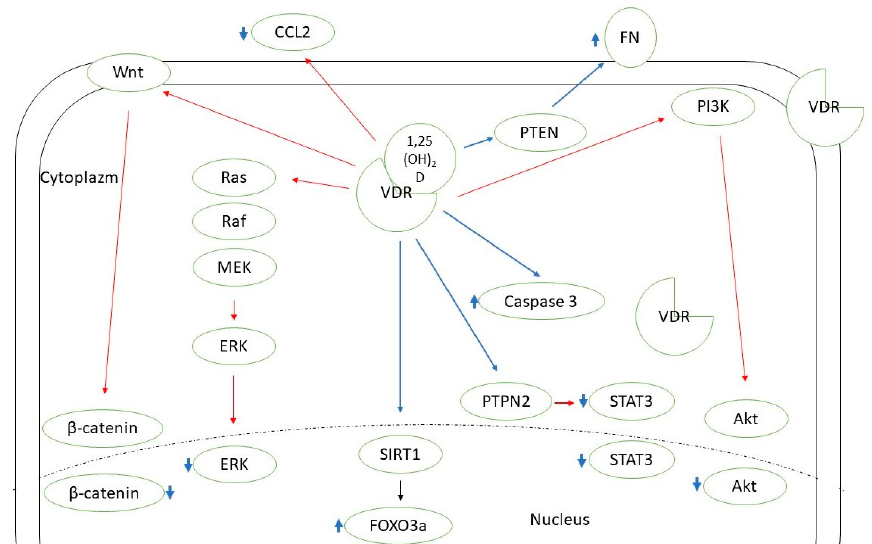
Figure 1. Known pathways mediating vitamin D action in thyroid cancer cells. CCL2—C-C motif chemokine ligand 2; ERK—extracellular signal-regulated kinase; FN—fibronectin; FOXO3a—fork- head box protein O3a; MEK—mitogen-activated protein kinase kinase 1; PI3K—phosphoinositide 3-kinase; PTEN—phosphatase and tensin homolog; PTPN2—protein tyrosine phosphatase N 2; SIRT1—sirtuin 1 histon deacethylase; STAT3—signal transducer and activator of transcription 3; VDR—vitamin D receptor. Red lines—inhibition; blue